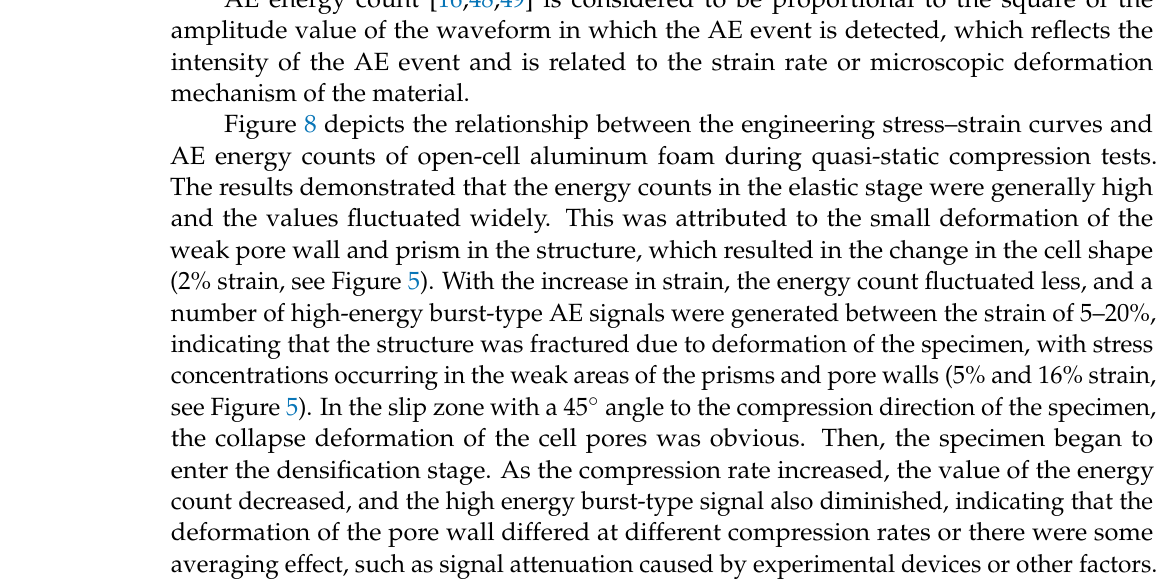
Figure 7. Engineering stress–strain curves and AE ring down count relationships at various compression rates: ( a ) 2 mm/min; ( b ) 10 mm/min; ( c ) 50 mm/min.